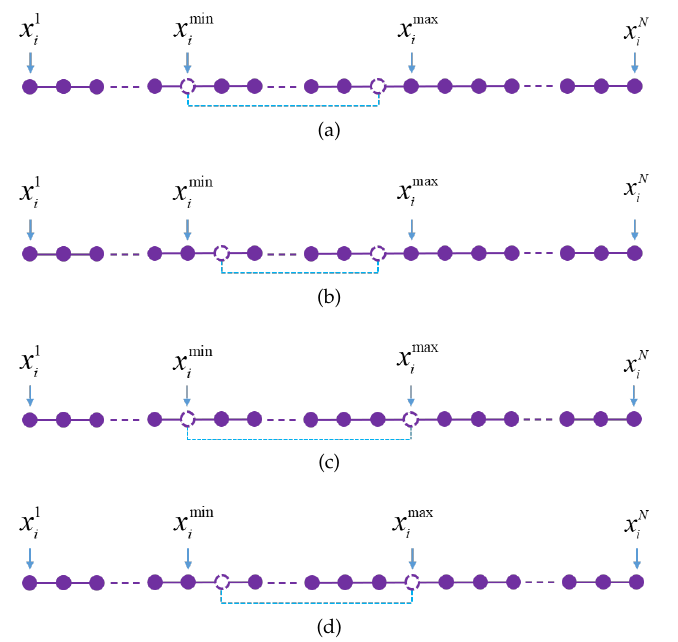
Figure 7. Dynamic neighborhood inversion mutation. ( a ) Reverse the order x min